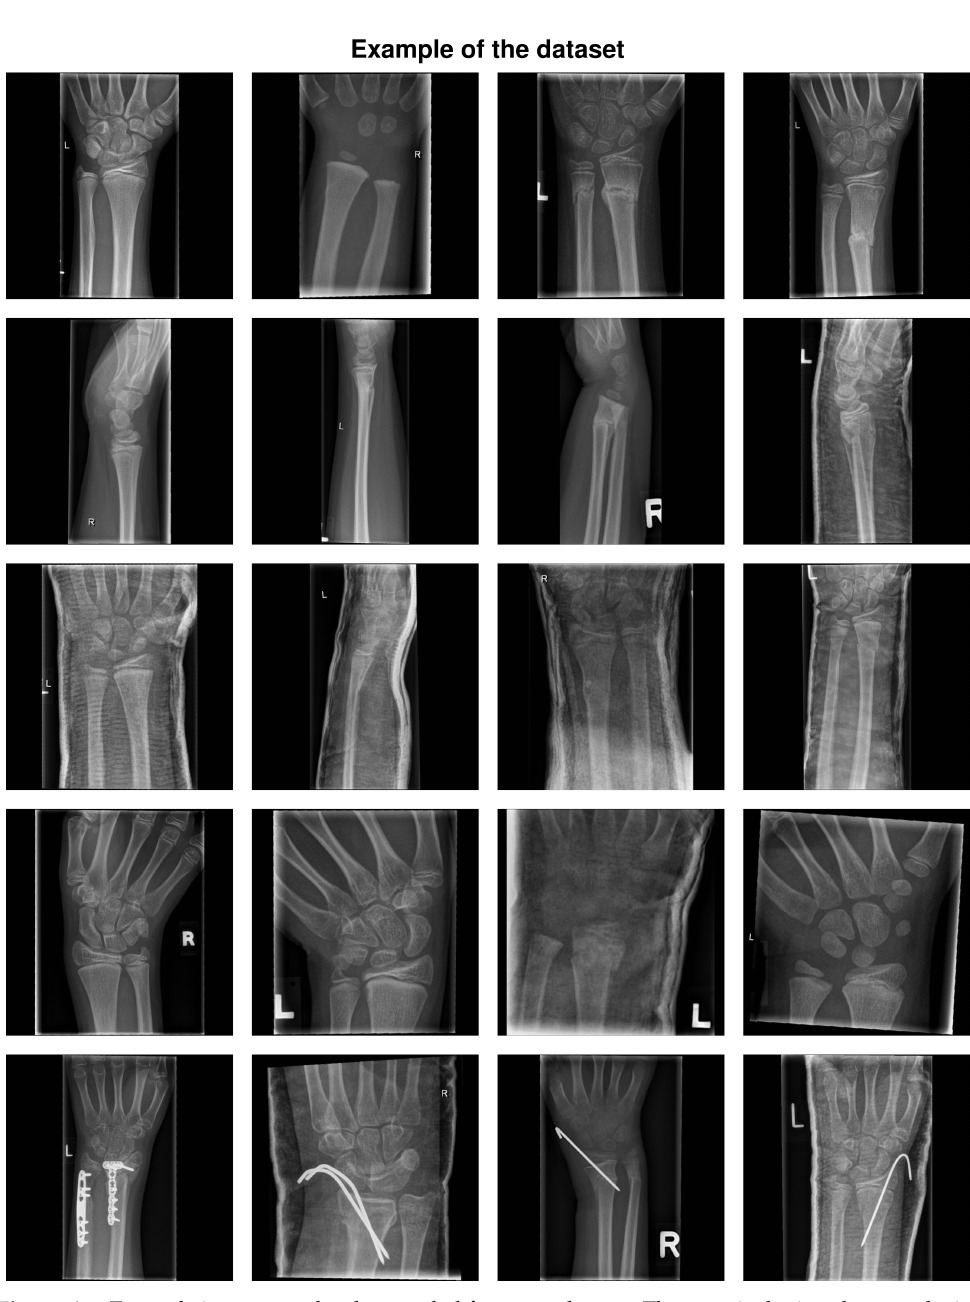
Figure A1. Example images randomly sampled from our dataset. The mosaic depicts the complexity of the dataset used in our research (e.g., various number of fractures, different projections, presence of cast and/or